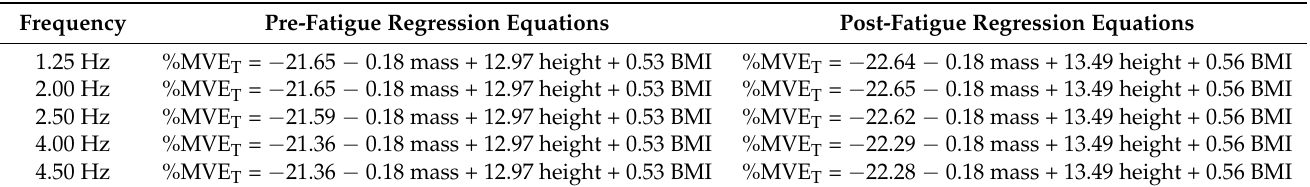
Table 6. Stepwise regression models for %MVE T (transformed % maximum voluntary electrical activation data) of the thoracic erector spinae pre- and post-back muscle fatigue, where mass, height, and body mass index (BMI) are continuous predictors, and vibration frequency is a categorical predictor.